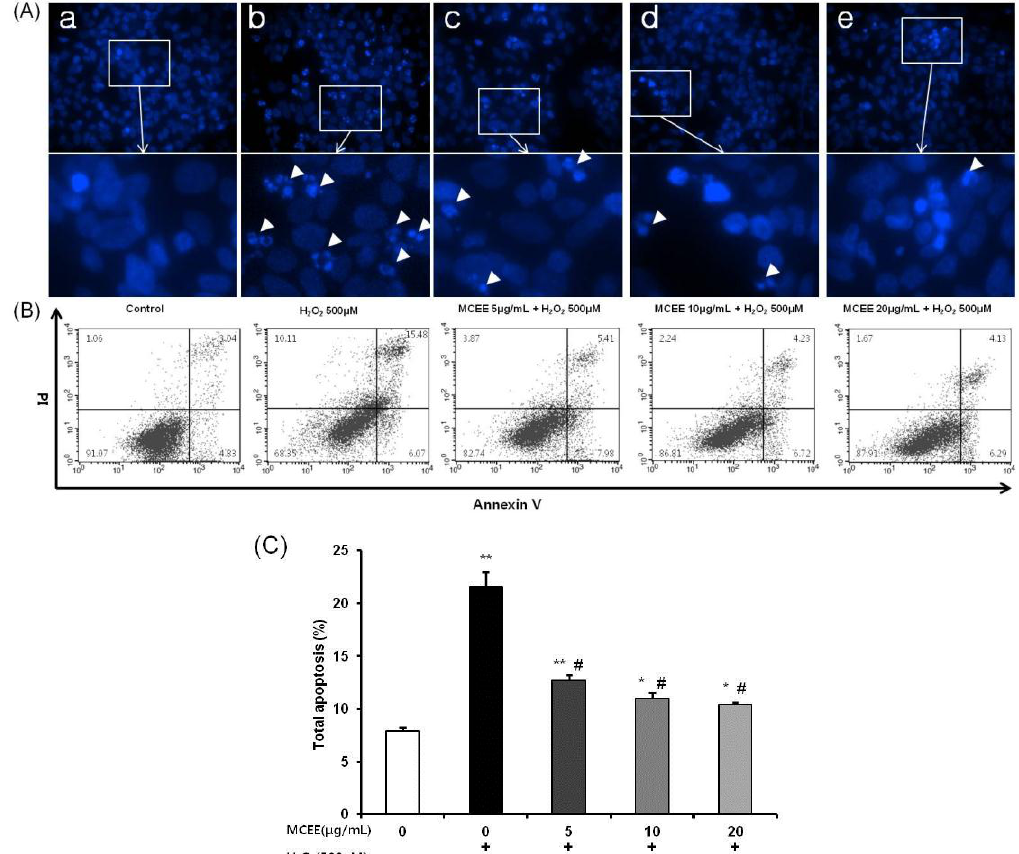
Figure 5. Effects of MCEE on apoptosis in H 2 O 2 -induced SK-N-MC cells. ( A ) Morphological changes of nuclear chromatin by Hoechst 33342 staining were observed using a fluorescence